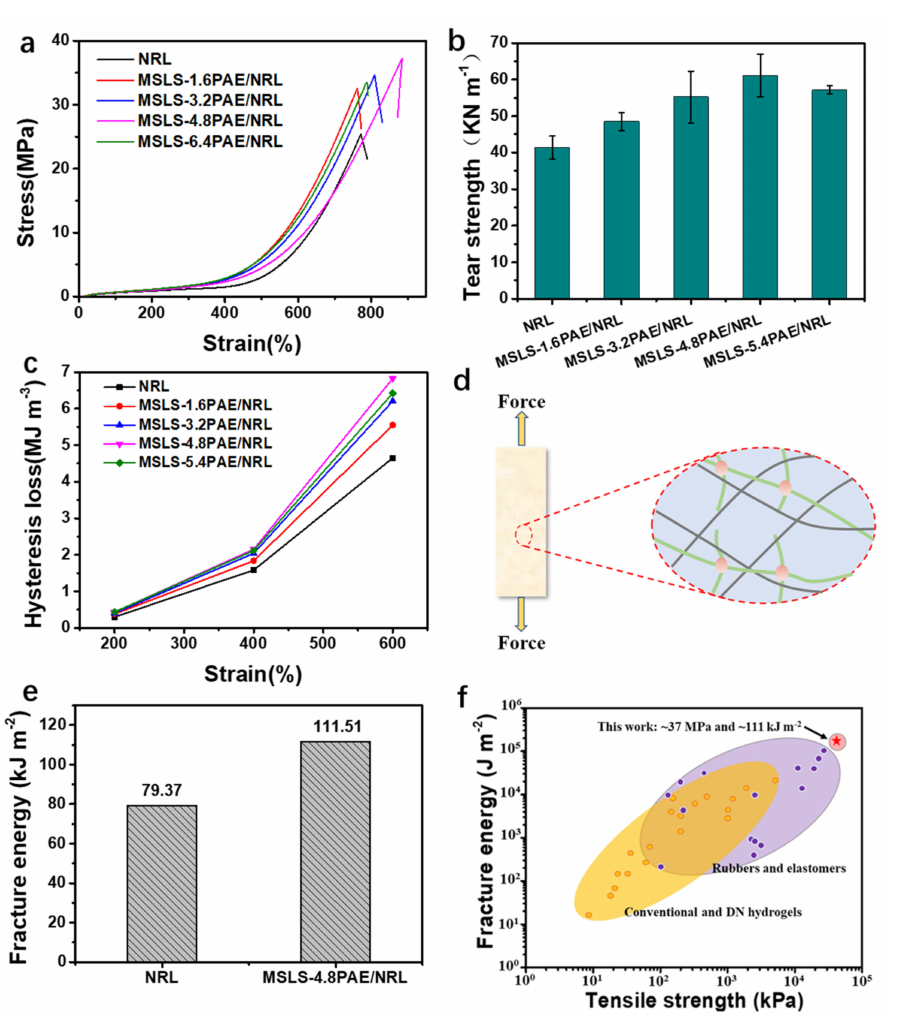
Figure 3. ( a ) Tensile strength, ( b ) tear strength, ( c ) the hysteresis loss of different materials under different strains, ( d ) the potential schematic illustration of the microstructure changes in MSLS-PAE- functionalized rubber matrix during stretching, ( e ) fracture energy of MSLS and MSLS-PAE/NRL, and ( f ) comparison of tensile strength and fracture energy of the obtained materials with other soft materials